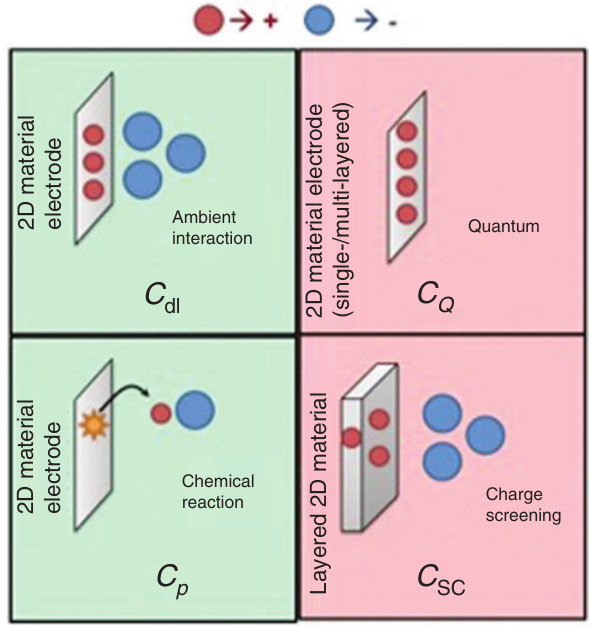
Figure 1: Schematic of a few manifestations of capacitance for a typical 2D material constituting an electrode (enabling